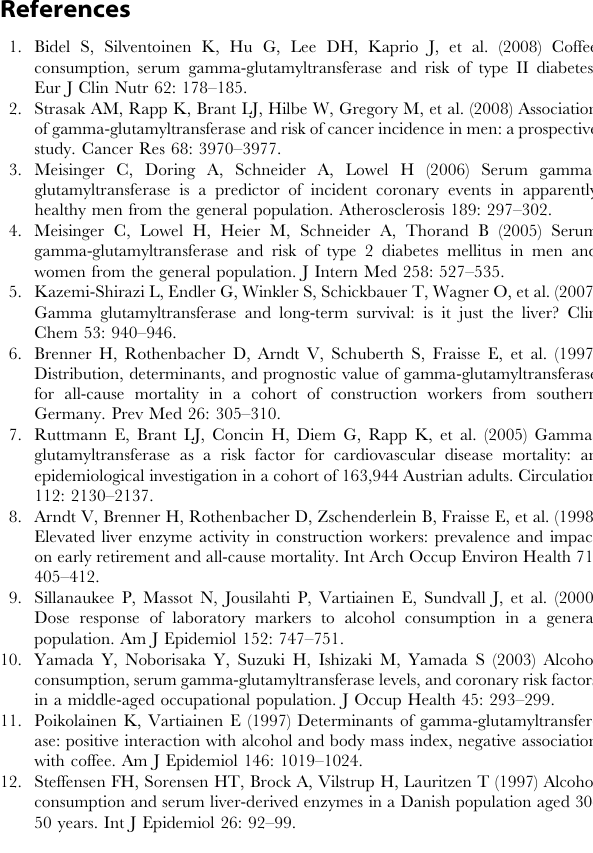
Table S1 Age- and body mass index-adjusted associations between smoking x alcohol consumption intensity strata and serum c -GT levels. Reported are odds ratios (OR) from logistic regression models predicting c -GT . 28 U/L (at 25 u C) and results from regression models predicting logarithmically transformed c - GT (expressed as % change in concentration).